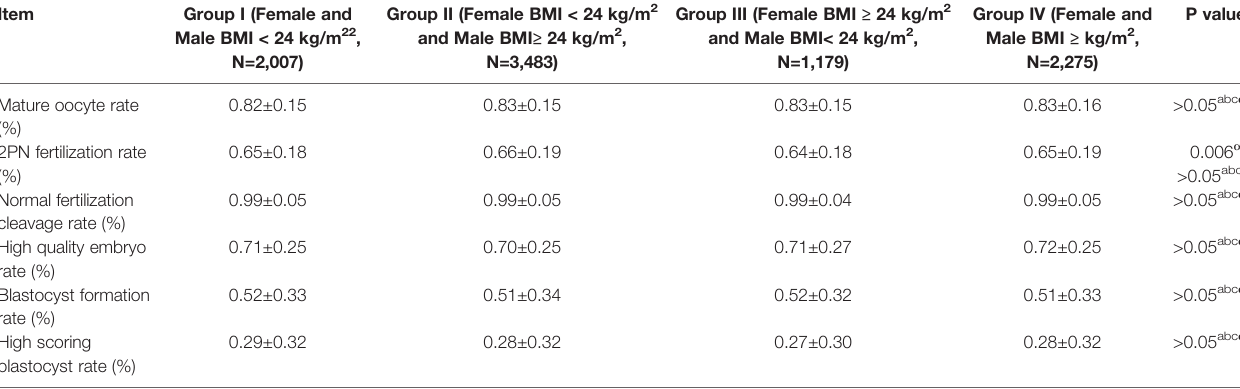
TABLE 2A | Effect of female or (and) male BMI on oocytes maturation, fertilization, embryo development, and embryo quality in IVF